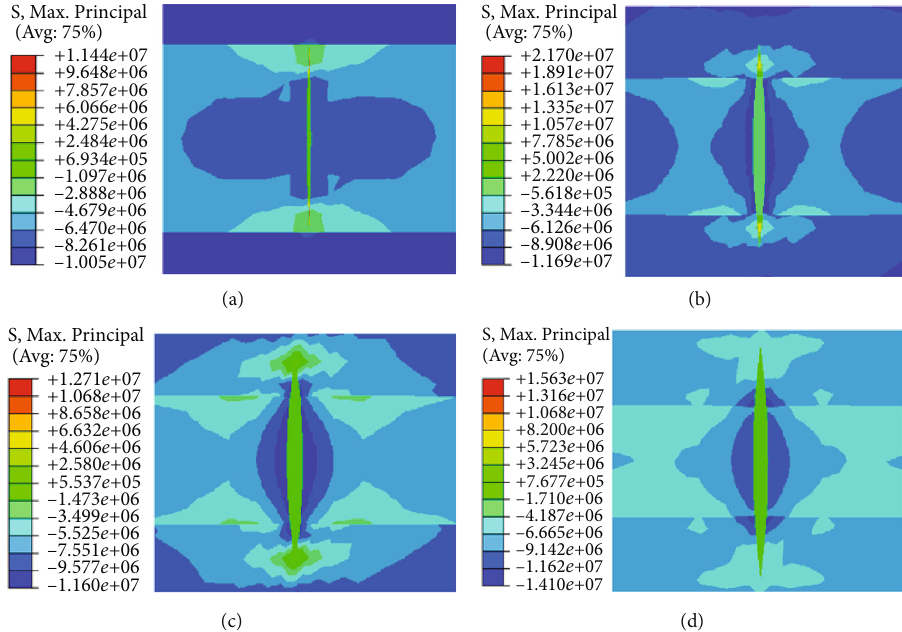
Figure 16: Development of hydraulic fracturing height after increasing the original injection rate at di ff erent times: (a) 10 steps, (b) 20 steps, (c) 40 steps, and (d) 50 steps.